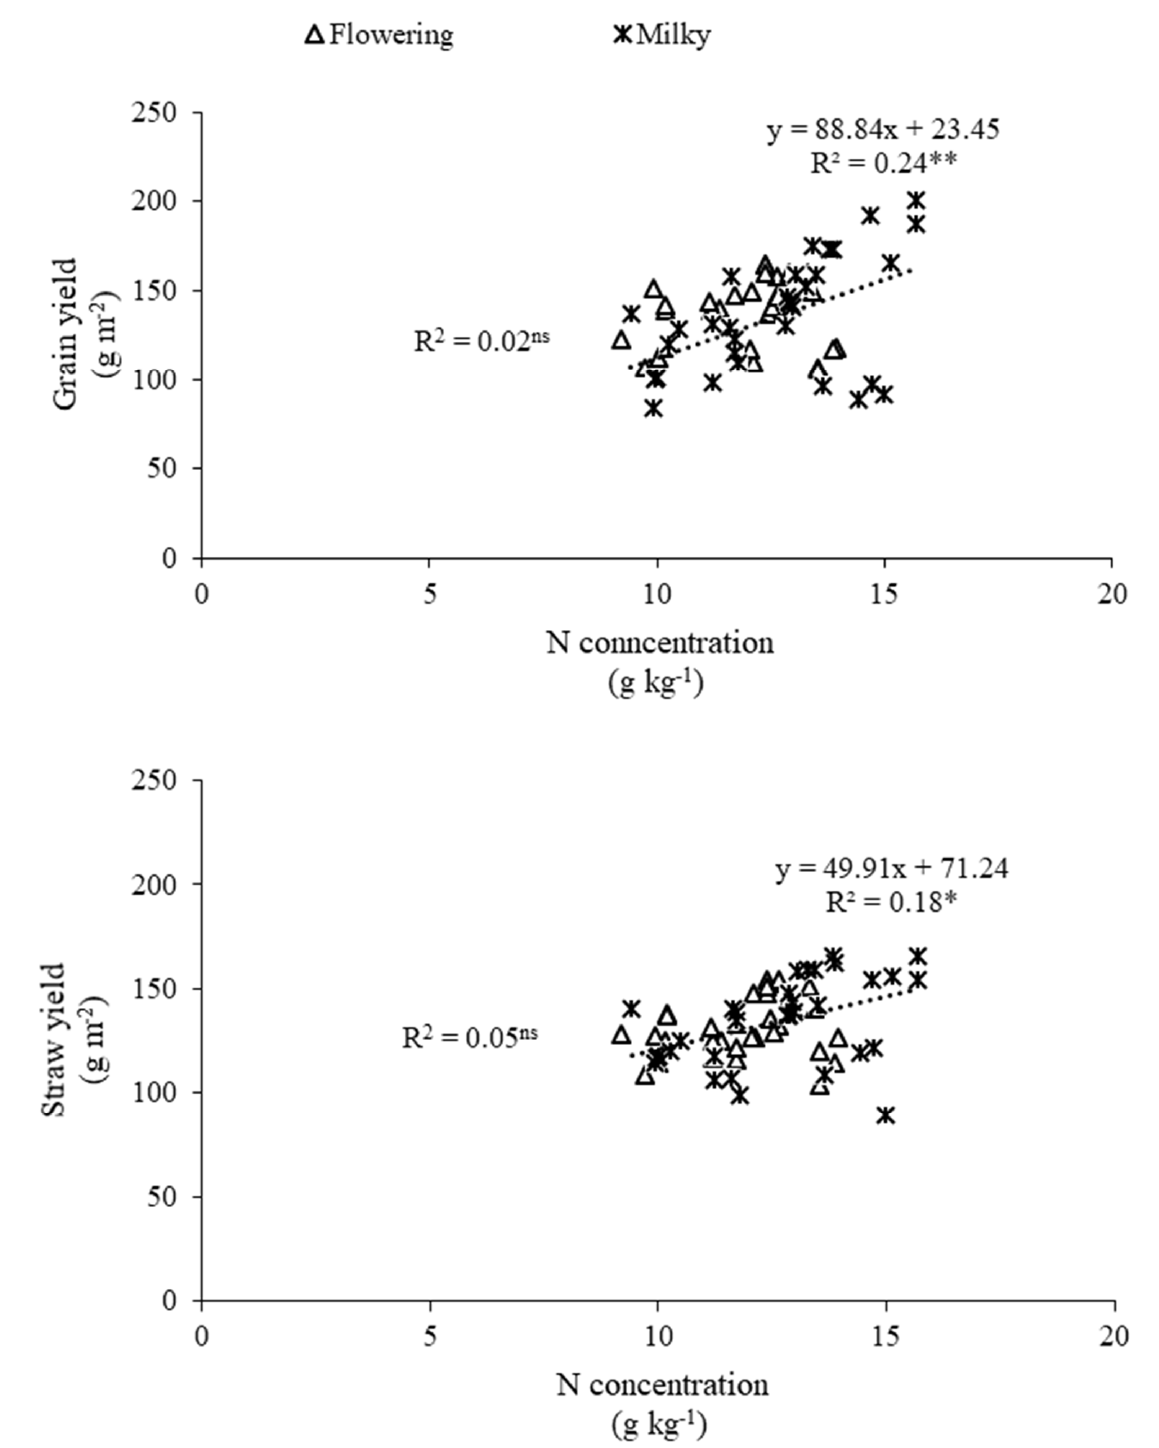
Figure 7. The relationship between N concentration and grain yield. N concentration and straw yield in brown rice of SPT1 variety grown at different foliar N and Zn fertilizer rates under variations of soil Zn fertilizer at the flowering and milky stages. ns , **, * indicate nonsignificant and significant linear regression at p < 0.01 and p < 0.05 ( n = 32), respectively.